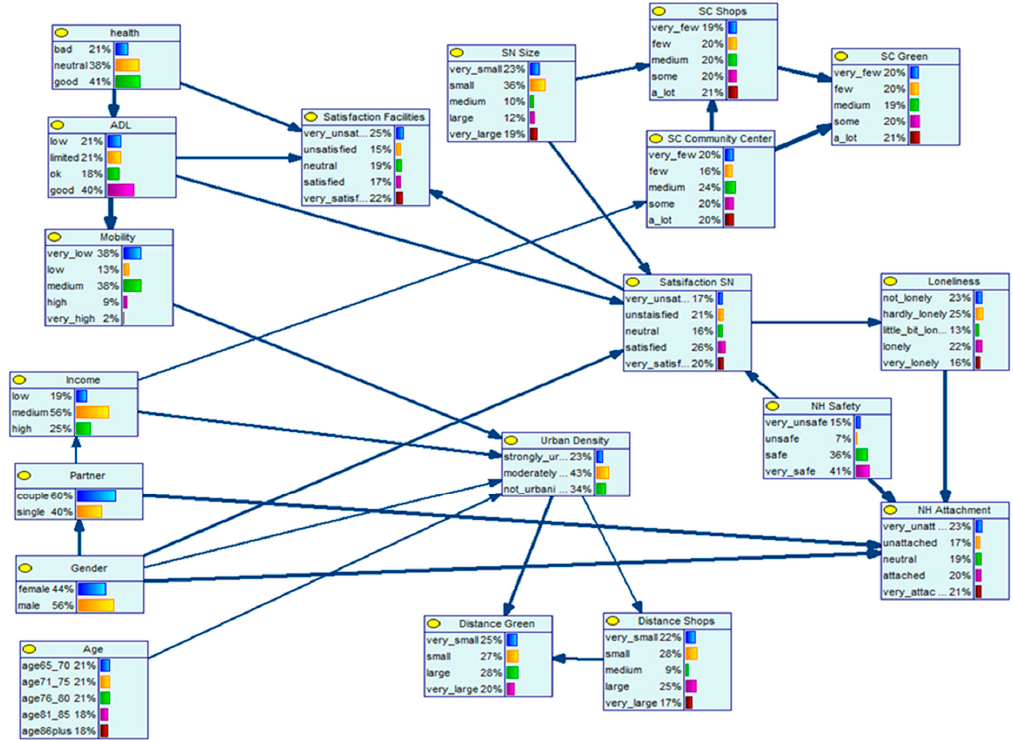
Figure 3. Bayesian belief network model with conditional probability tables. SN: Social Network, SC: Social Contacts, NH: Neighborhood.